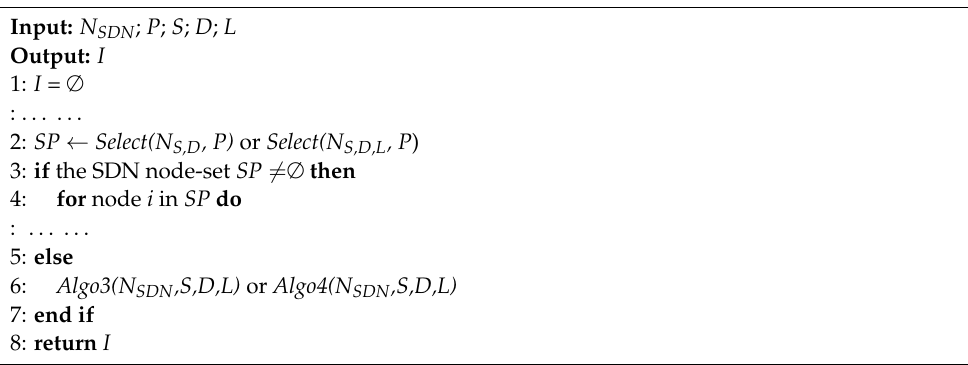
Algorithm A2 Hybrid Approach—T or ECMP-T or Fermat-point